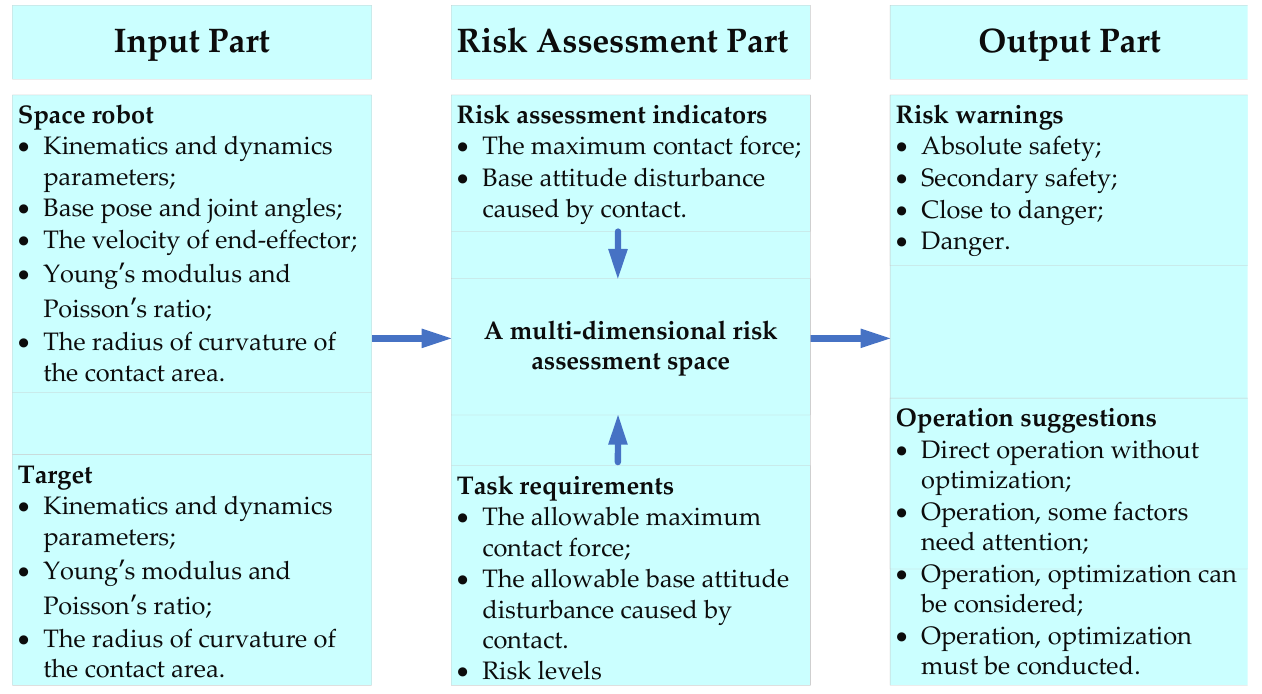
Figure 4. Three parts of proposed risk assessment method.